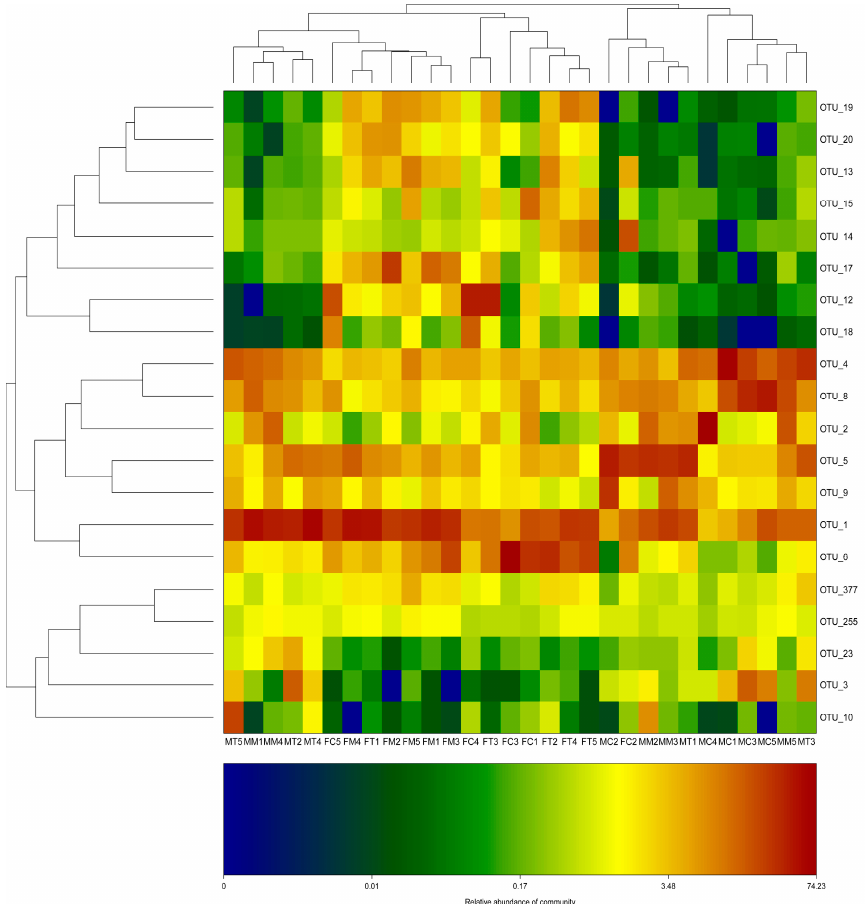
Figure 4. Distribution of OTUs in intestinal mucosa and fecal samples plotted as a heat map. The data were normalized to proportional abundance and are represented from low (blue) to high (red) for each OTU. OTUs indicate operational taxonomic units. FC, FM, and FT denote the control group, the model group, and the Tiansi-treated group of fecal samples, respectively; MC, MM and MT denote the control group, the model group and the Tiansi-treated group of intestinal mucosa samples, respectively.